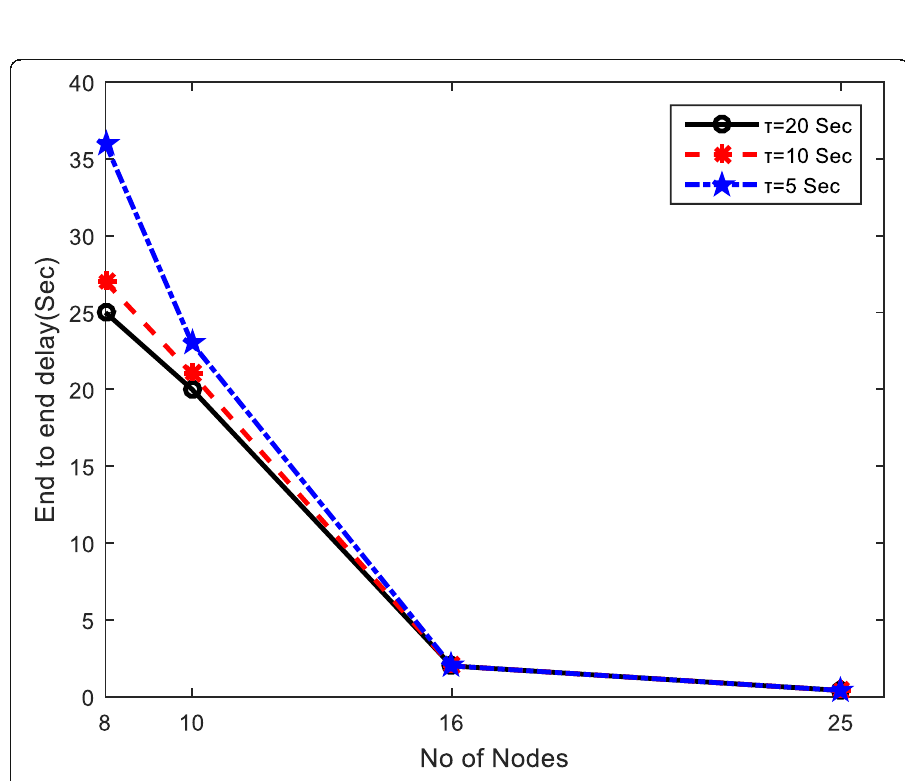
Fig. 12 End-to-end delays performance of T-OLSR ( τ = 20, 10, 5 s; Ф = 2 s)